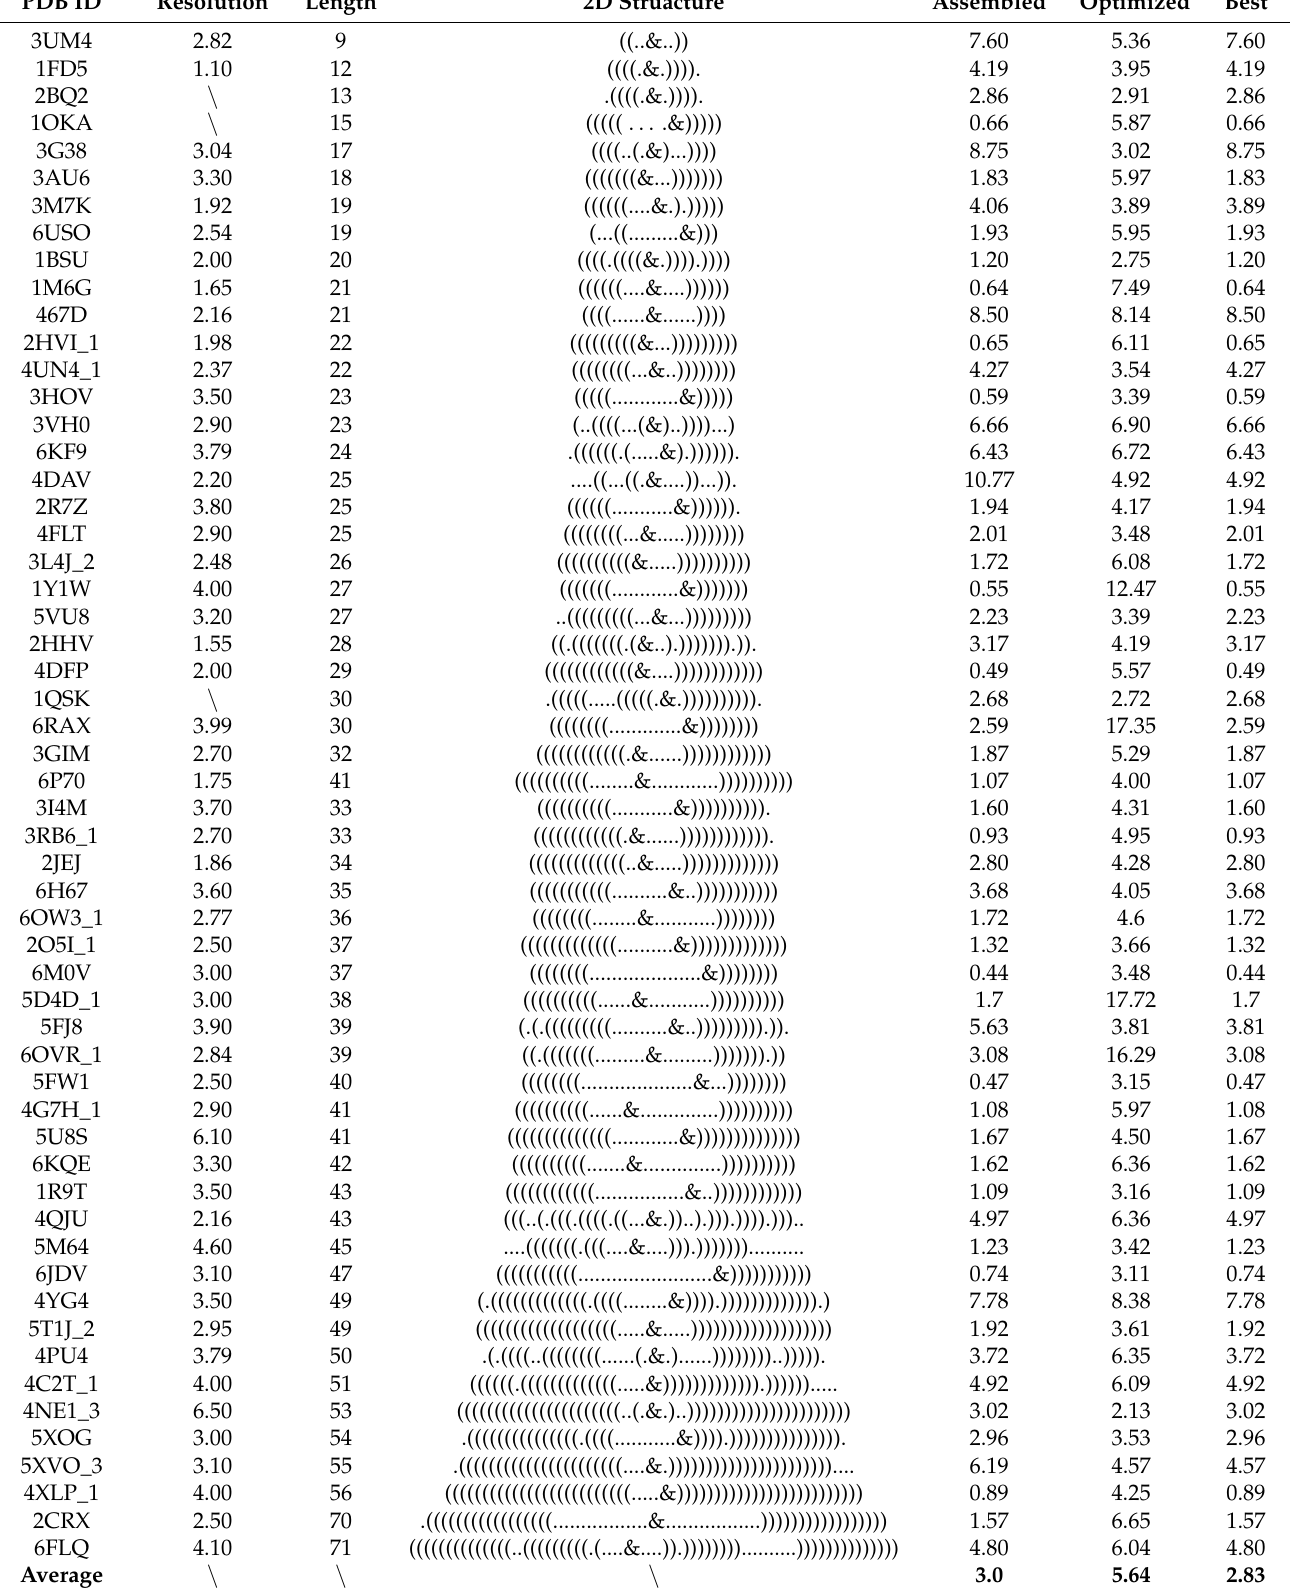
Table 2. Information and prediction accuracies (RMSD in Å) of 56 double-chain